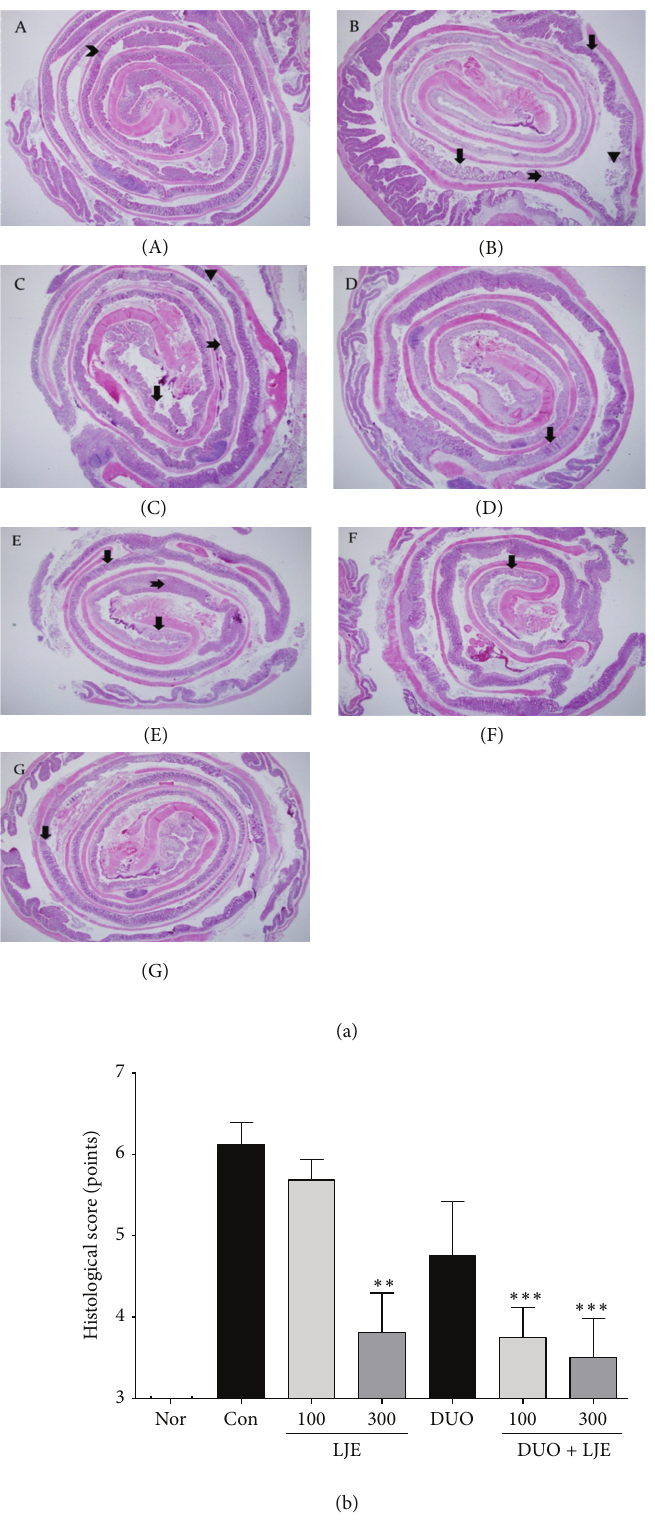
Figure 4: (a) Effects of LJE or DUO on histological findings in DSS-induced colitis. (a)-(A): normal, (a)-(B): control, (a)-(C): LJE 100, (a)-(D): LJE 300, (a)-(E): DUO, (a)-(F): DUO + LJE 100, (a)-(G): DUO + LJE 300, chevron: normal crypt, down arrow: cryptal damage, notches right arrow: infiltration of inflammatory cell, and reversed triangle: ulcer. The whole colon tissues were stained by (H) and (E). The center was the distalpartandtheboundarywastheproximalpartofcolon( × 20).(b)EffectsofLJEorDUOonhistologicalscoresinDSS-inducedcolitis.Nor: normal mice without any treatment, Con: mice provided with only 5% DSS treatment, LJE: the water extract of Laminaria japonica , DUO: Duolac7S, LJE + DUO: cotreatment of LJE and DUO, 100: the dosage of LJE 100mg/kg, and 300: the dosage of LJE 300 mg/kg; ∗∗ 𝑃 < 0.01 , ∗∗∗ 𝑃 < 0.001 versus control group analyzed by one-way ANOVA with Dunnett’s post hoc